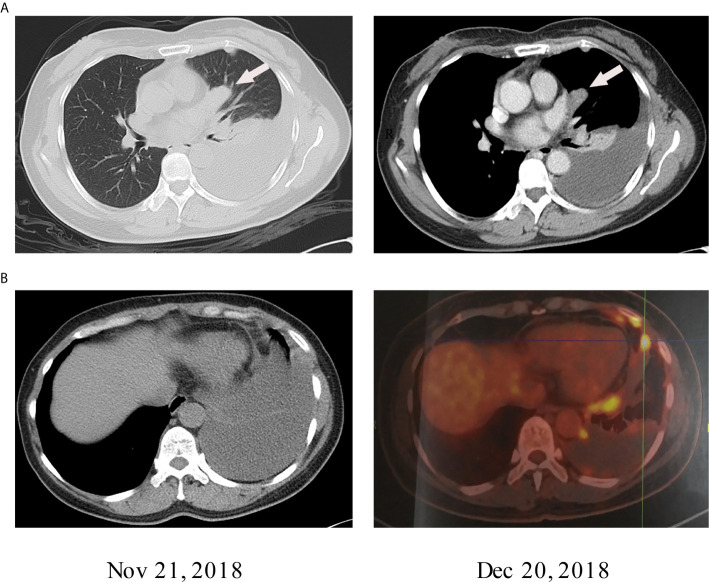

(A) The lung windows show 2.3 cm × 2 cm nodules with uniform density next to the heart margin of the left lung segment. Contrast-enhanced CT of mediastinal windows shows that the nodules were uniformly strengthened. (B) The PET-CT results of the patient on December 20, 2018, showed a decrease in pleural effusion compared to the PET-CT results on November 21, 2018.